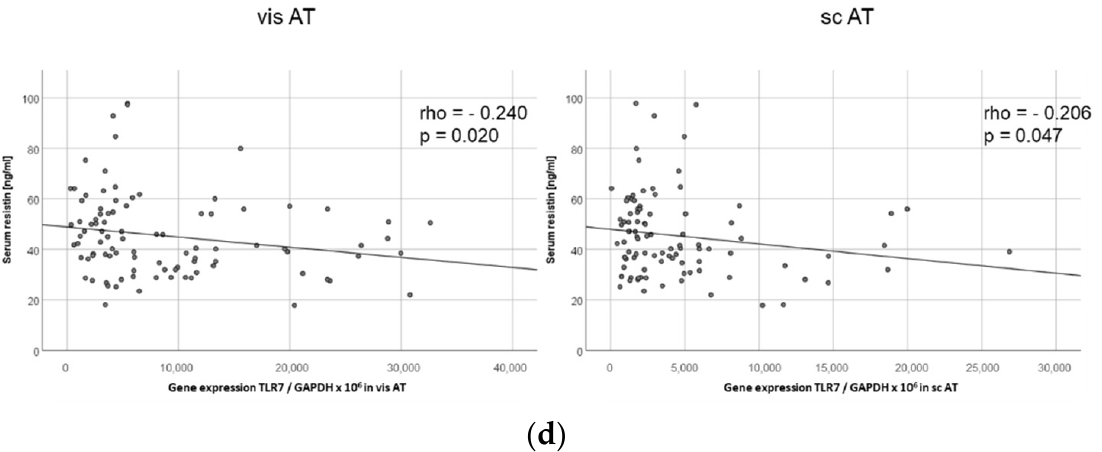
Figure 7. TLR7 is significantly increased in visceral as compared to subcutaneous adipose tissue in non-diabetic obese patients undergoing bariatric surgery and negatively correlates with resistin serum levels. TLR7 gene expression (normalized to GAPDH expression) was quantified via RT-PCR in surgically obtained paired samples of subcutaneous (sc) and visceral (vis) adipose tissue (AT) from 95 obese, non-diabetic patients (14 men, 81 women) undergoing bariatric surgery. ( a ) TLR7 expression levels were significantly increased in visceral as compared to subcutaneous AT ( n = 95); ( b ) no significant correlation was observed between TLR7 and TLR9 mRNA expression in visceral or subcutaneous AT ( n = 95); ( c ) visceral AT TLR7 expression was significantly correlated to subcu- taneous TLR7 expression ( n = 95); ( d ) both visceral and subcutaneous AT TLR7 expression levels correlated negatively with resistin levels in the systemic circulation ( n = 94).